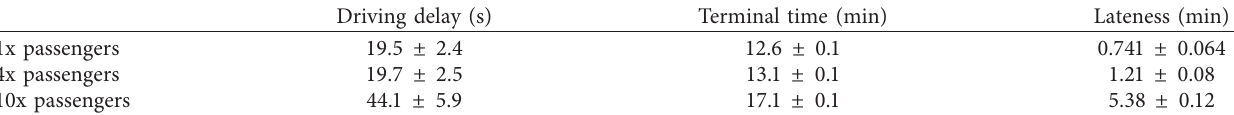
Table 2: Results for the increased number of passengers scenario in the form of average values with 95% confidence